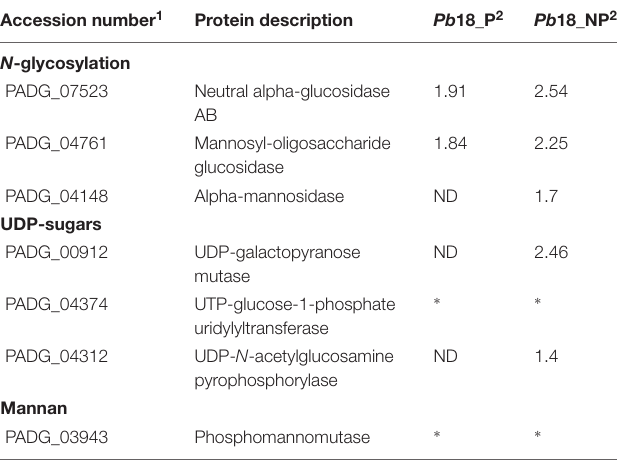
TABLE 2 | Up-regulated proteins putatively related to the homeostasis of cell wall componets in Pb 18_A and Pb 18_NA.